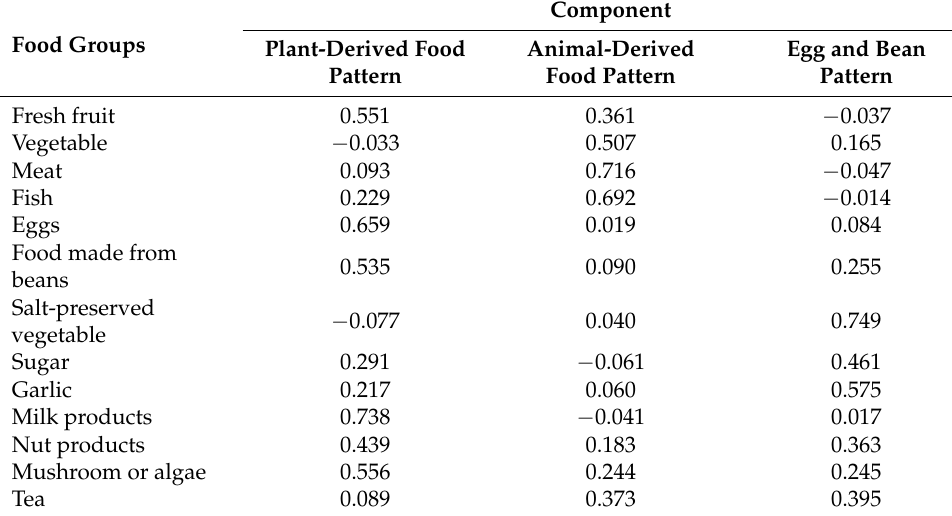
Table A6. Dietary pattern factor